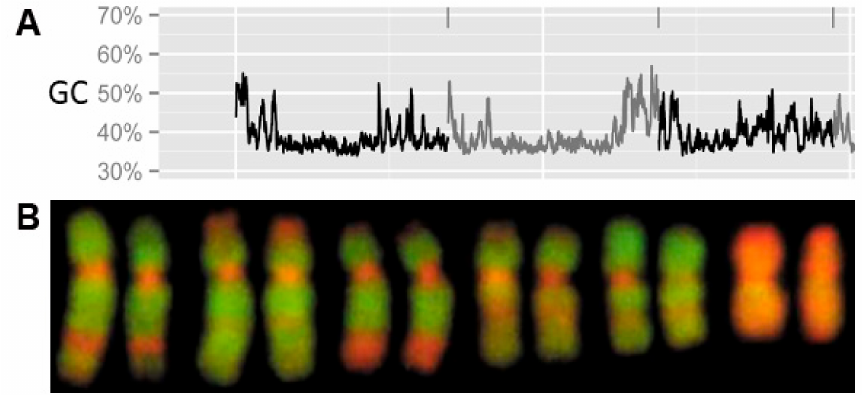
Figure 2. ( A ) GC-profiles across three linkage groups (LGs) so far unassigned to their corresponding chromosome pairs showing fluctuations in GC-percentage produced using the chromoplot tool. These three linkage LGs are arranged according to their numbers in the Ensembl [103] and separated by vertical lines above profiles and by the alternation of gray and black colors ( x -axis—genome position, y -axis—GC%); ( B ) Partial karyotype stained with 4',6-diamidino-2-phenylindole/ Chromomycin A 3 (DAPI/CMA 3 ) showing six pairs of larger chromosomes of the spotted gar with altering GC-rich regions in red and AT-rich regions in green. Reproduced with permission from